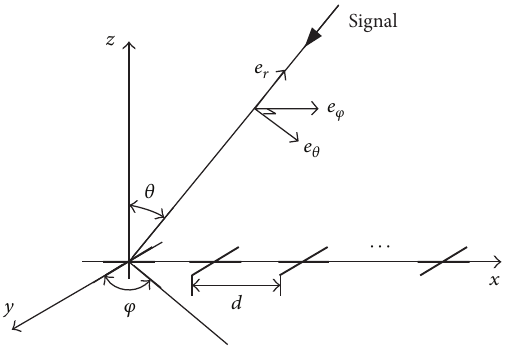
Figure 1: Uniform linear array